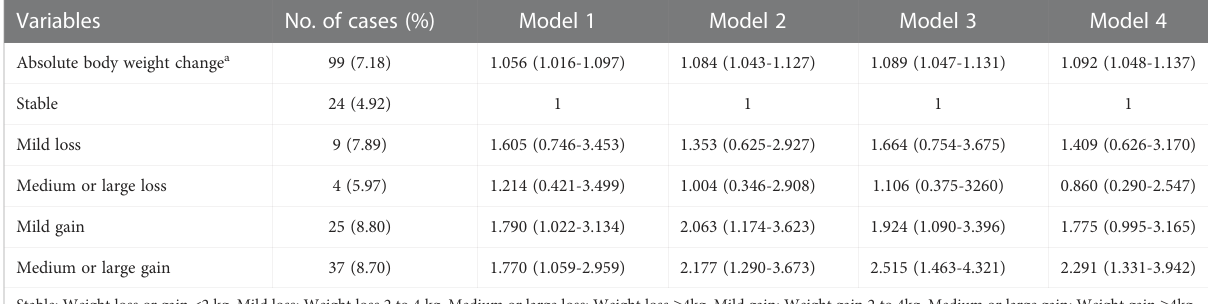
TABLE 3 Associations between absolute body weight change and risk of metabolic abnormalities in subjects with non-overweight/obesity.